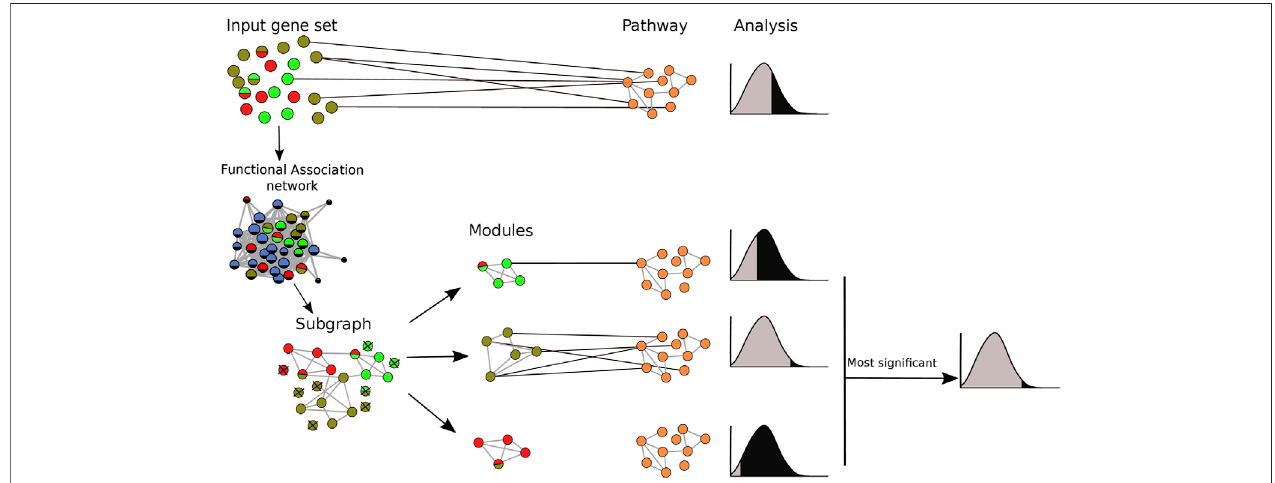
FIGURE 2 | Integrating clustering methods into pathway enrichment analysis. The input gene set was mapped onto an association network and clustering algorithms were applied. Based on this, the gene set was divided into several modules, and pathway enrichment analysis was run for each of the modules separately, keeping only the most signi fi cant result for each module-pathway pair. Pathway enrichment was also run in the original gene set for comparison purposes. Each node represents a gene. Different colors refer to membership in different modules or pathways. A multicolored circle indicates more than one membership.